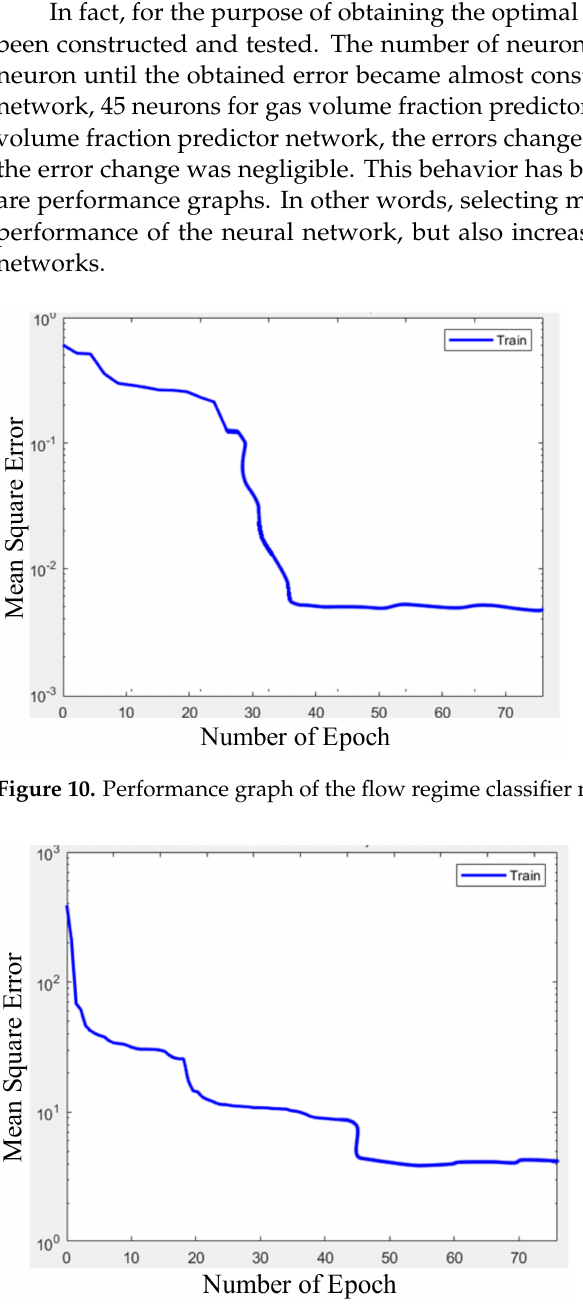
Figure 11. Performance graph of the gas volume fraction predictor